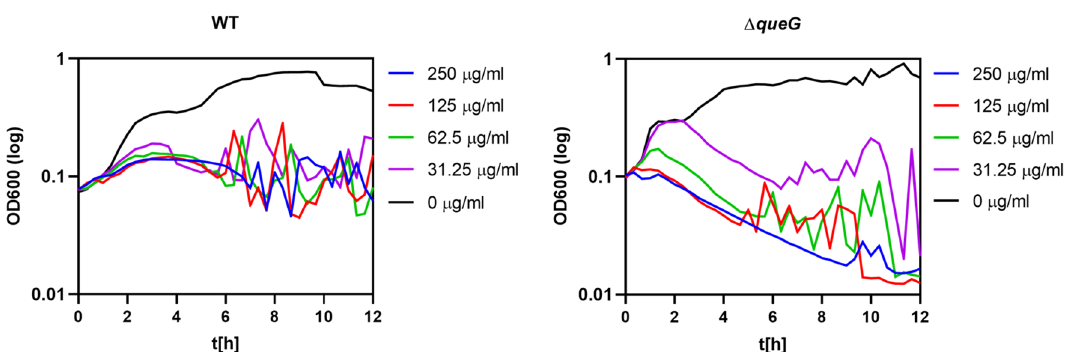
Figure 4. Susceptibility of B. subtilis 168 ∆ queG mutant to lethal concentrations of kanamycin. Growth curves for WT B. subtilis 168 and ∆ queG in the presence of increasing concentrations of kanamycin. The black curve indicates the outgrowth of cells without